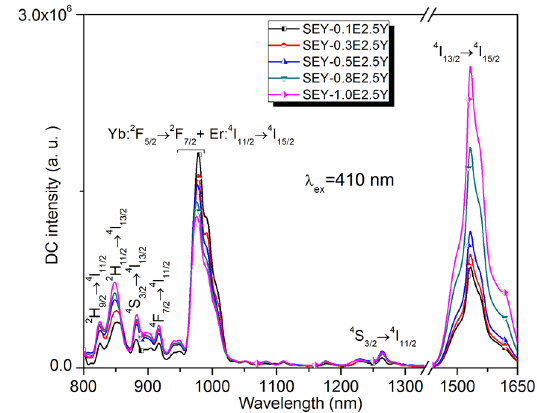
Figure 8. DC emission spectra of SEY-0.1E2.5Y, SEY-0.3E2.5Y, SEY-0.5E2.5Y, SEY-0.8E2.5Y and SEY-1.0E2.5Y transparent glass-ceramics samples.